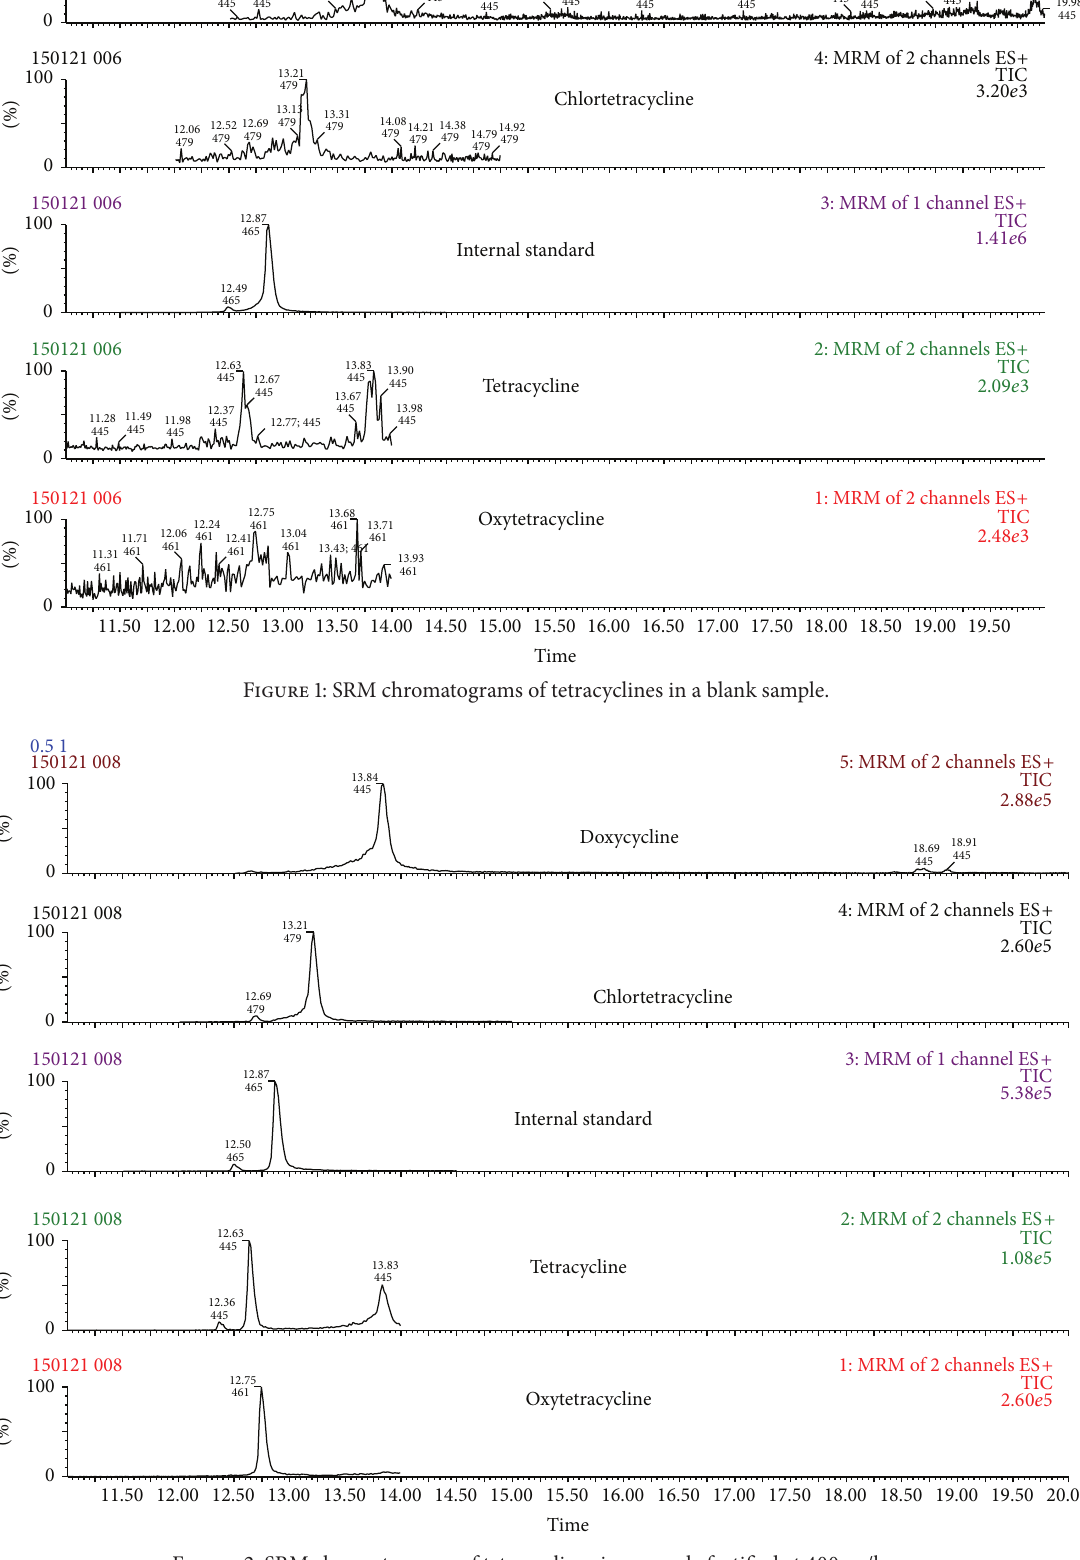
Figure 2: SRM chromatograms of tetracyclines in a sample fortified at 400 𝜇